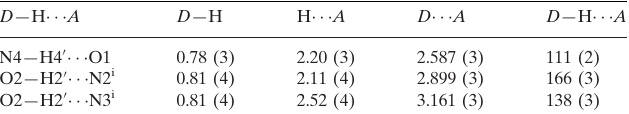
Hydrogen-bond geometry (A˚ , (cid:3)